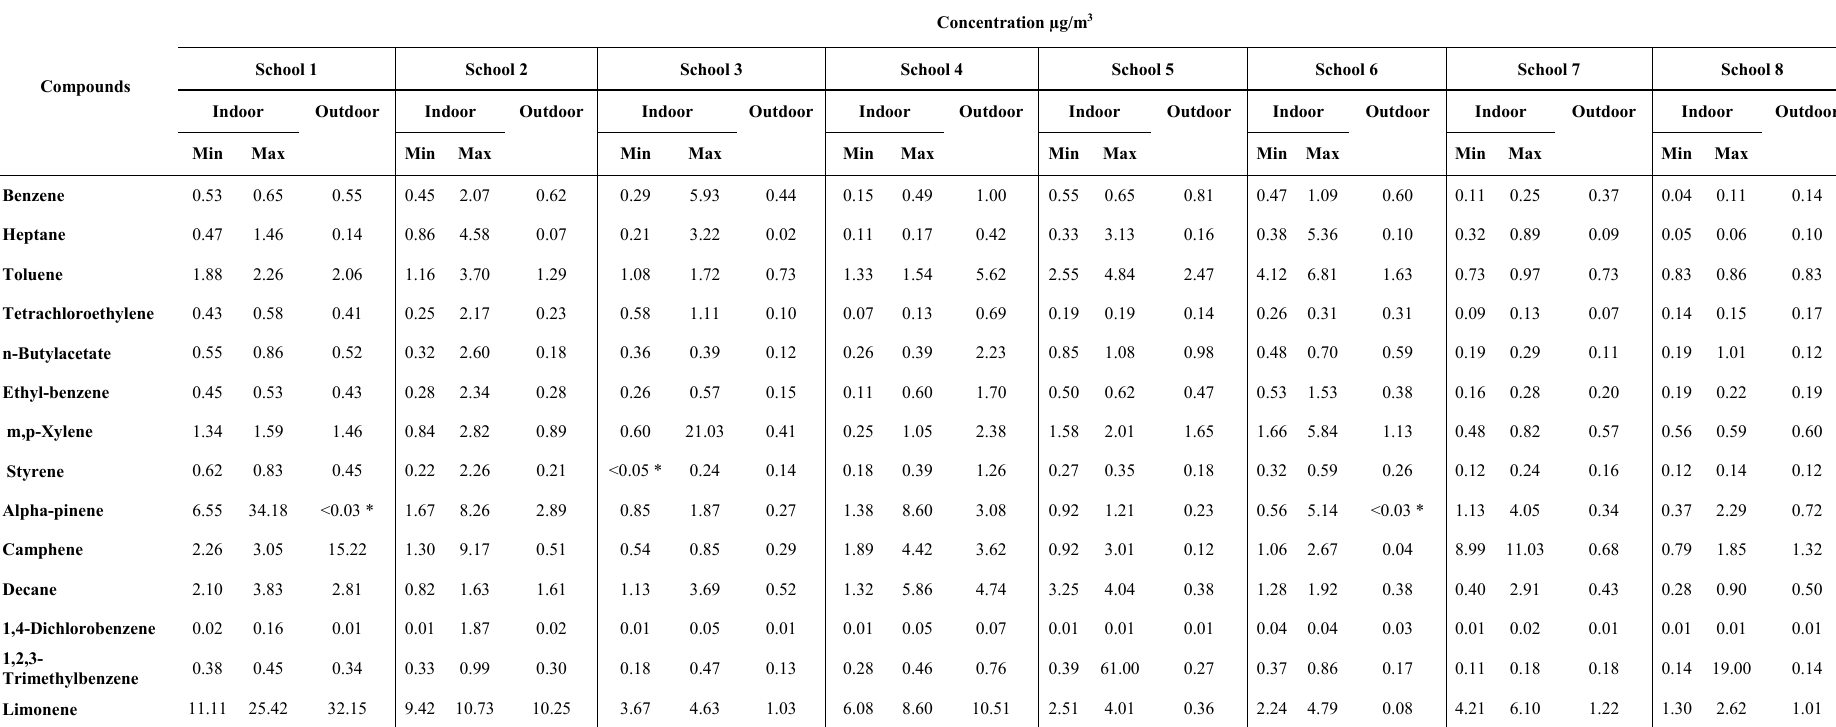
Table 4. VOC concentrations at monitored